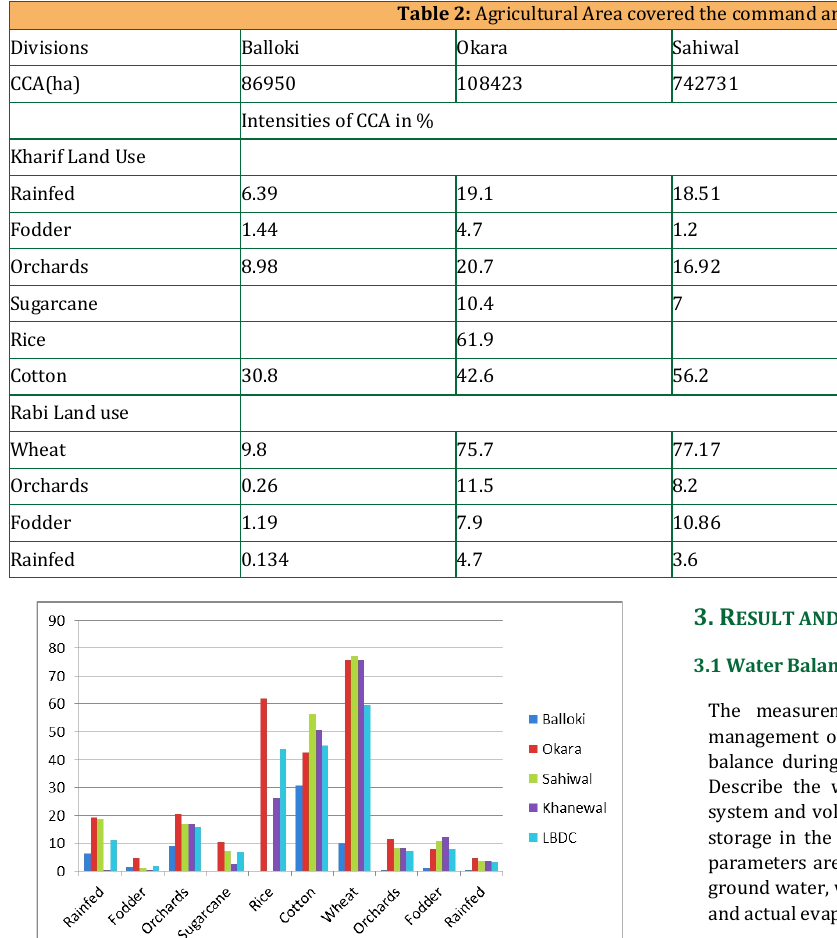
Figure 2: crop covered the CCA of